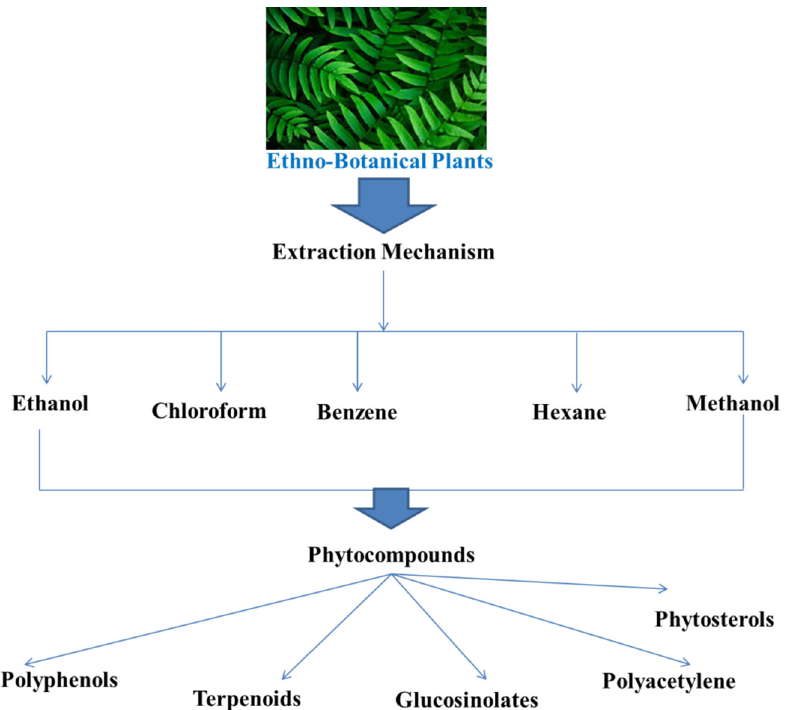
Figure 3. Plant derived compounds as effective anti-biofilm agent.